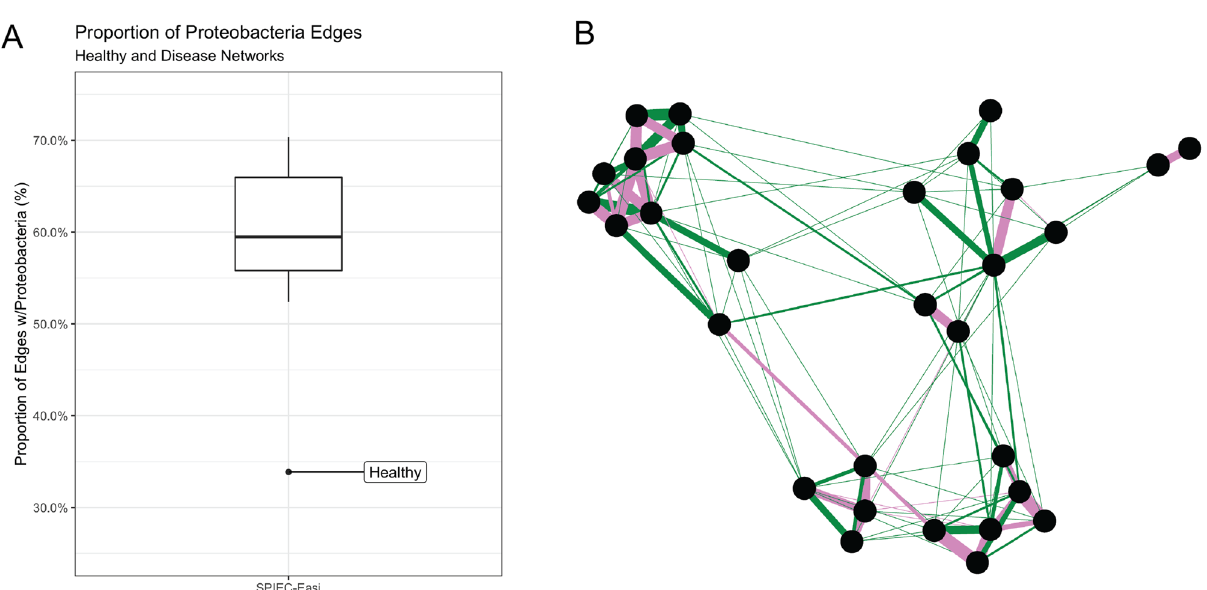
Figure 7. Proteobacteria interactions in microbial networks. ( A ) Distribution of the fractions of interactions that involve Proteobacteria in healthy and diseased microbiome association networks. In the boxplot, the Y-axis represents the proportion of interactions involving Proteobacteria. ( B ) Subgraph containing the largest Proteobacteria module found in consensus network. Consensus network contains edges shared between 5 or more disease networks. Green edges represent edges that are not found in the healthy network, while pink edges represent edges in the consensus network that are also found in the healthy network. Edge weight is scaled by the count of networks that a given edge is observed